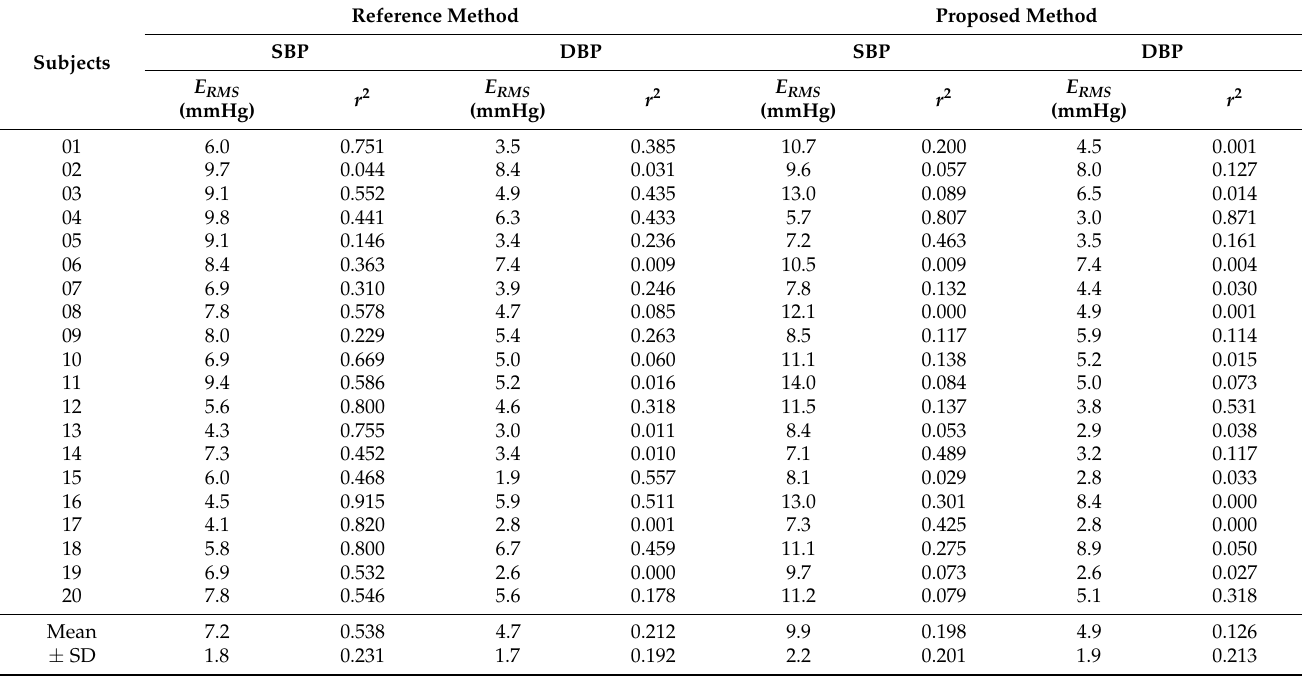
Table 3. Results of estimated SBP and DBP with Equation (4) for the reference and proposed